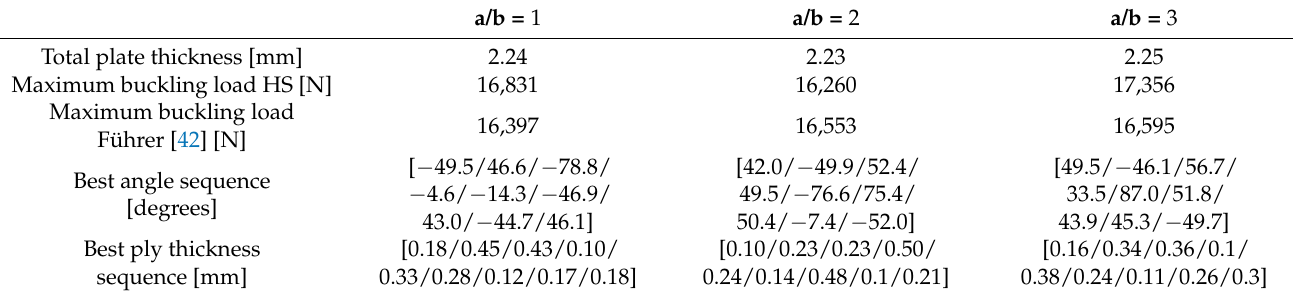
Table 5. The results of the harmony search optimization for the CFRP plates with rectangular cut-outs.